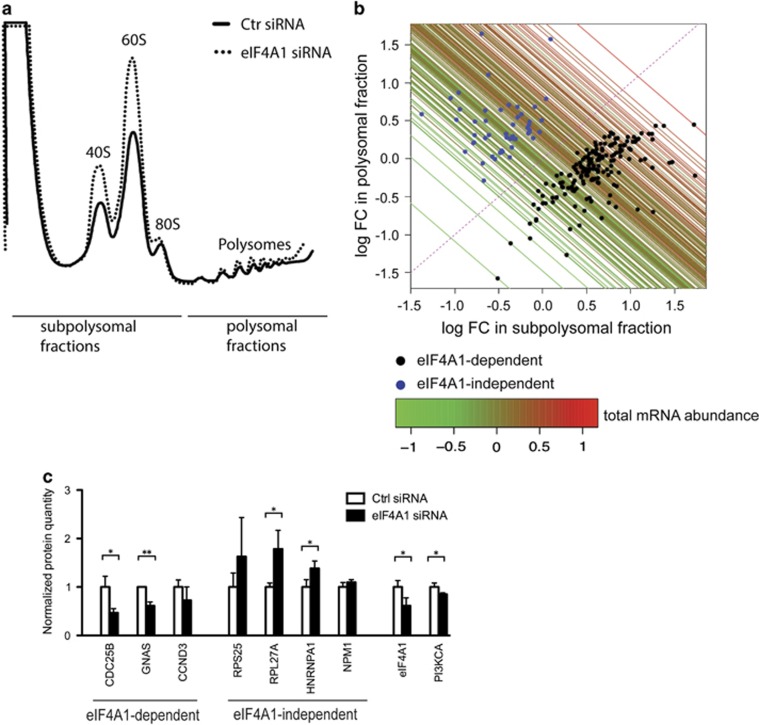
A subset of mRNAs is dependent on eIF4A1 for efficient translation. MCF7 cells were transfected with either control siRNA or anti-eIF4A1 siRNA and analyzed 48 h post-transfection. (a) Polysome analysis of RNA. Ribosomes were stalled with cycloheximide and mRNAs separated according to their ribosome load by sucrose-gradient centrifugation. The positions of the 40S, 60S and 80S ribosomal subunits and polysomal peaks are indicated, as well as fractions pooled for subsequent mRNA analysis. (b) Identification of eIF4A1-dependent and -independent messages. mRNAs from pools indicated in control and eIF4A1 knockdown MCF7 cells were quantified by RNA sequencing (the experiment was performed in quadruplicate). The Bayesian model was applied to identify mRNAs that show significant shifts between polysomes and subpolysomes following eIF4A1 knockdown. Each mRNA identified was plotted according to log-fold change in the subpolysomal and polysomal fractions; mRNAs below y=x are translationally downregulated (eIF4A1-dependent mRNAs) and mRNAs above y=x show the reverse tendency (eIF4A1 independent). Colored lines drawn through each mRNA plot point show the change in the separately quantified total mRNA abundance. This confirms that in general the modeled changes in fractionated mRNAs are reflected at the total mRNA level, that is, an mRNA seen to go up in both subpolysomal and polysomal fractions generally shows an increased total abundance. (c) Immunoblot analysis of protein levels of eIF4A1-dependent and -independent messages. Translationally upregulated proteins increase at the protein level and vice versa. The experiment was performed in triplicate. Significance indicated by *<0.05 and ***<0.01